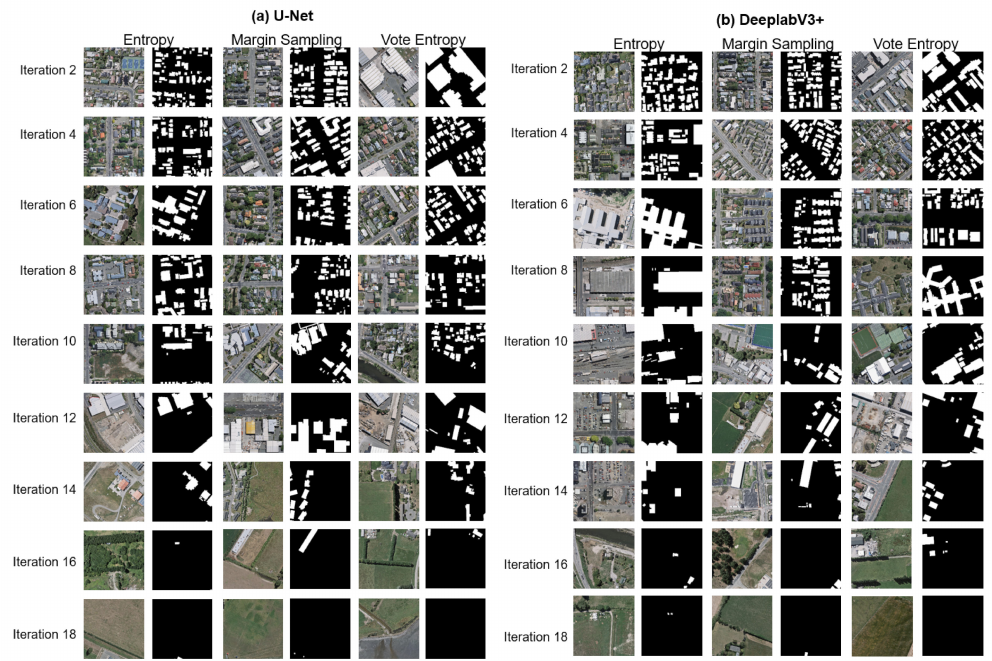
Figure 9. Example of image–label pairs selected by active learning strategies based on U-Net ( a ), DeeplabV3+ ( b ), and WHU aerial